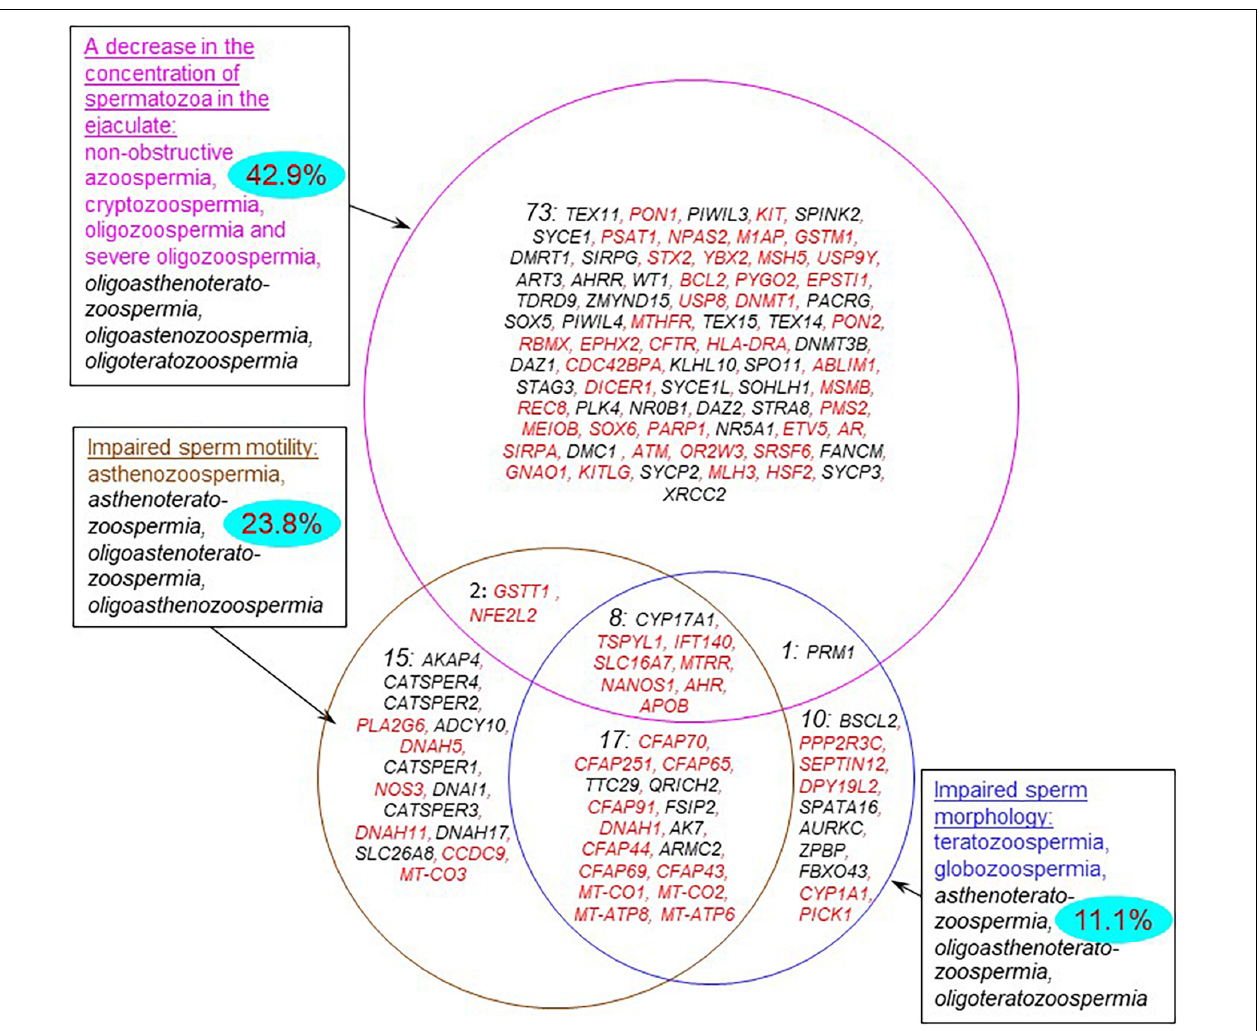
FIGURE 4 | Genes from the catalog associated with various forms of sperm abnormalities. The forms of pathozoospermia are presented in rectangular frames. Combined forms of pathozoospermia are shown in black and italics . The numbers in each part of the circles indicate the numbers of genes in each group. The blue ovals show the percentage of genes that control the response to adverse factors ( response to oxidative stress, response to oxygen-containing compound, response to stress, response to toxic substance) . Genes that are expressed in testis-enriched or testis-specific manner are shown in black; the other genes are shown in